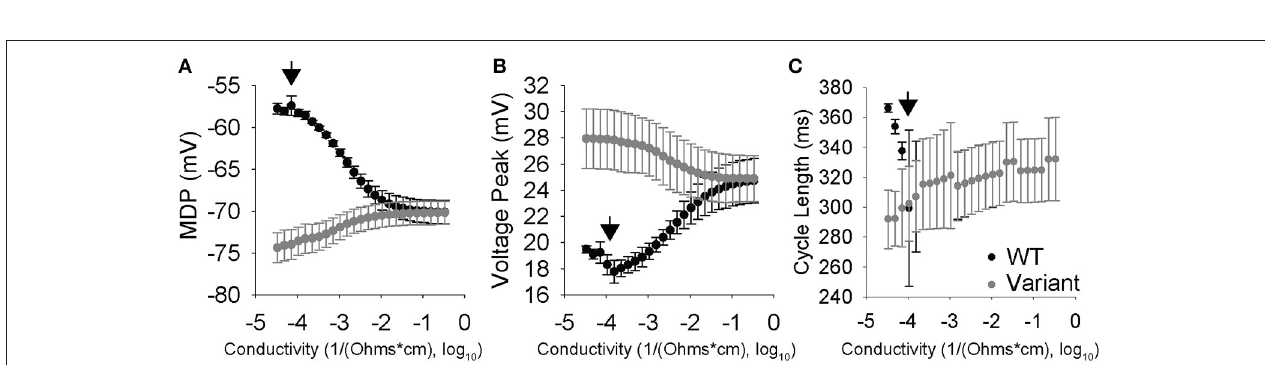
FIGURE 5 | Partial least-squares regression analysis of ionic gating variables vs. cell conductivity. Two cells were paired where one was lognormally perturbed with a mean of 1 and a standard deviation of 0.2, while the other cell was WT. 616 simulations were run at each conductivity for the least-squares regression at each of 10 different conductivities. Regression coefficients are shown over a range of gap junction conductivities for: (A) Max voltage, (B) cycle length, (C) max diastolic potential, (D) diastolic depolarization rate.